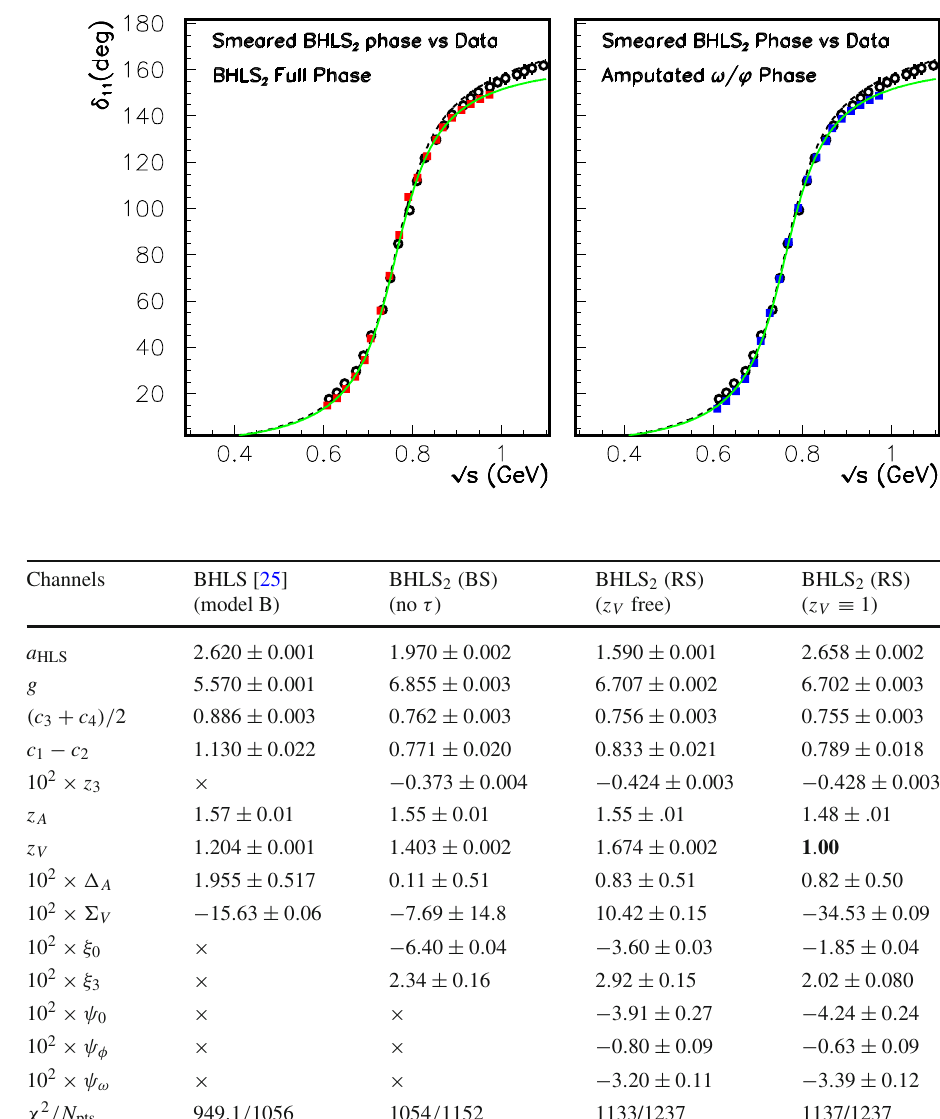
values in BHLS and in the BS and RS variants of BHLS 2 ;